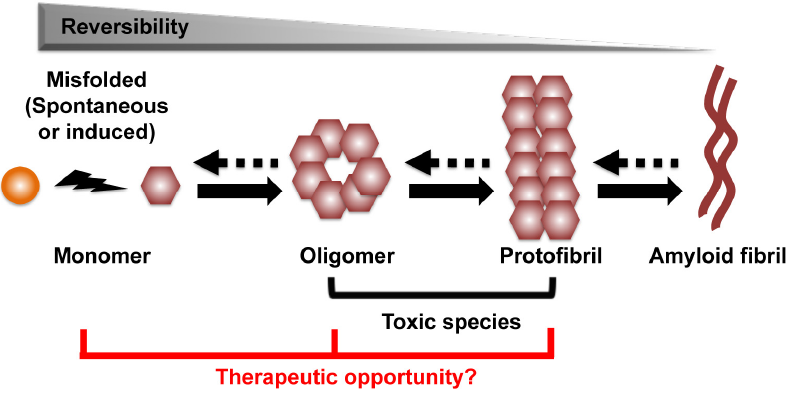
Figure 1. The process of amyloid formation. The first step of the process can be a conversion from the native α -helix rich soluble cellular protein into the pathogenic β -sheet rich isoforms, in which they are able to self-assemble through a variety of subsequent nucleation and growth steps to form oligomer, protofibril, and eventually amyloid fibril aggregates. Oligomer and protofibril are putative toxic species that drive neuronal dysfunction. We hypothesize the therapeutic targets are monomer, oligomer and